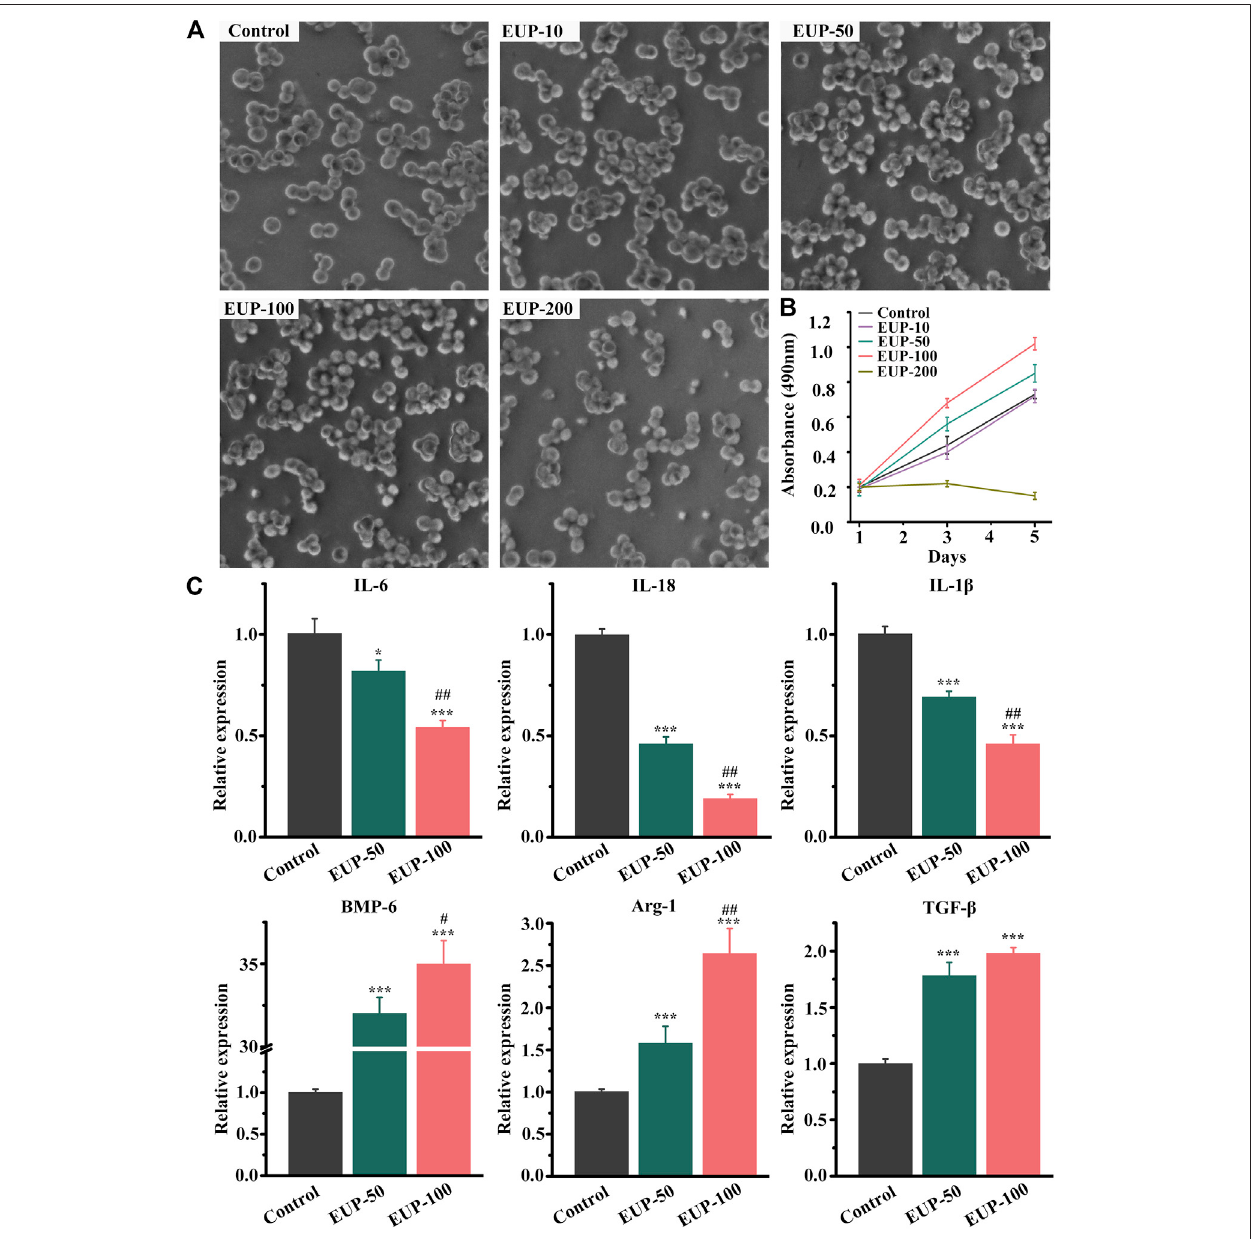
FIGURE 2 | Cell viability and gene expression of macrophages in Eucommia ulmoides polysaccharides (EUP) culture. (A) The morphology of macrophages in different concentrations of EUP culture. (B) The proliferation curve of macrophages was observed under different concentration culture conditions. (C) The relative expression of related genes in EUP culture. * p ＜ 0.05,*** p ＜ 0.001 stands for signi fi cant difference compared with the control group. # p ＜ 0.05, ## p ＜ 0.01 stands for signi fi cant difference compared with the EUP-50